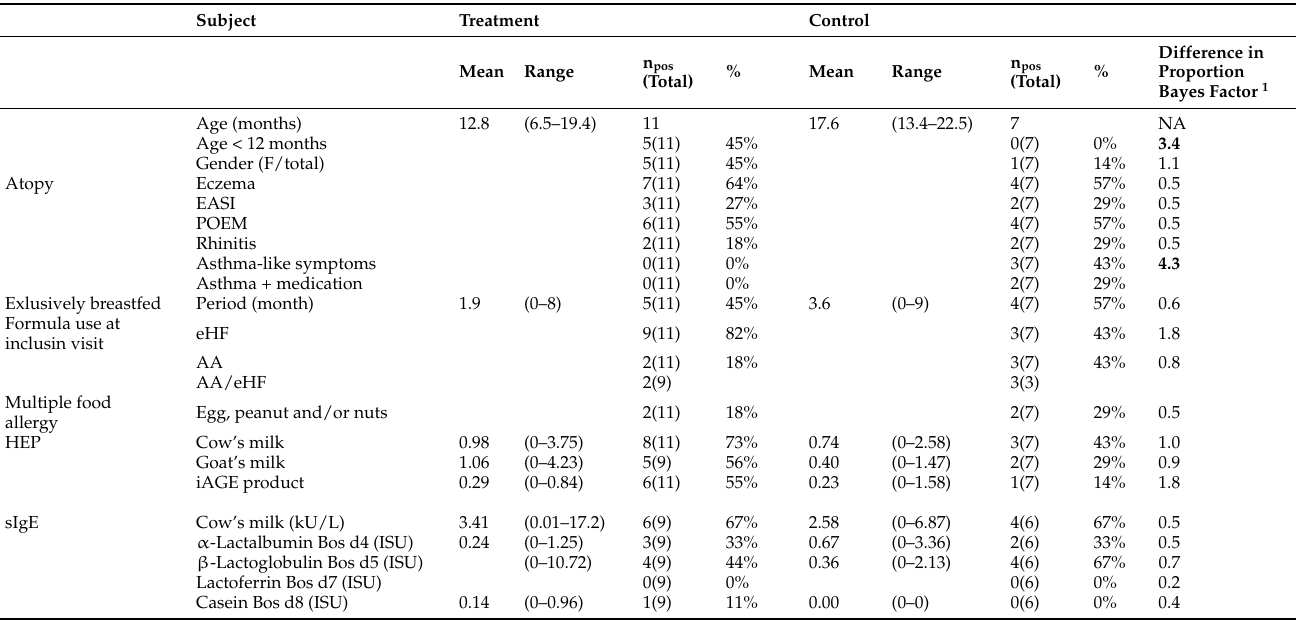
Table 3. Baseline characteristics of the 18 children participating in the